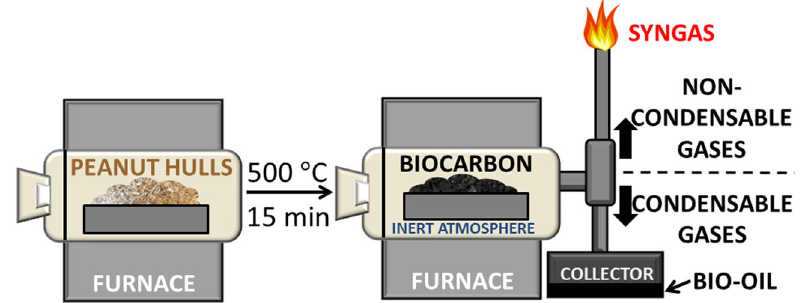
Figure 2. Vertical pyrolysis apparatus for biocarbon synthesis drawn by